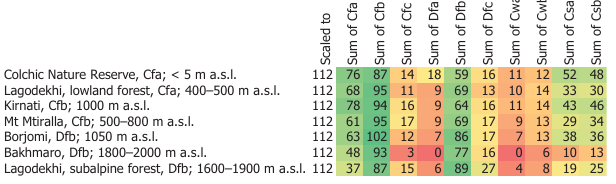
Fig. 7. Köppen climate type distribution and frequency in modern forest communities of humid temperate Georgia,